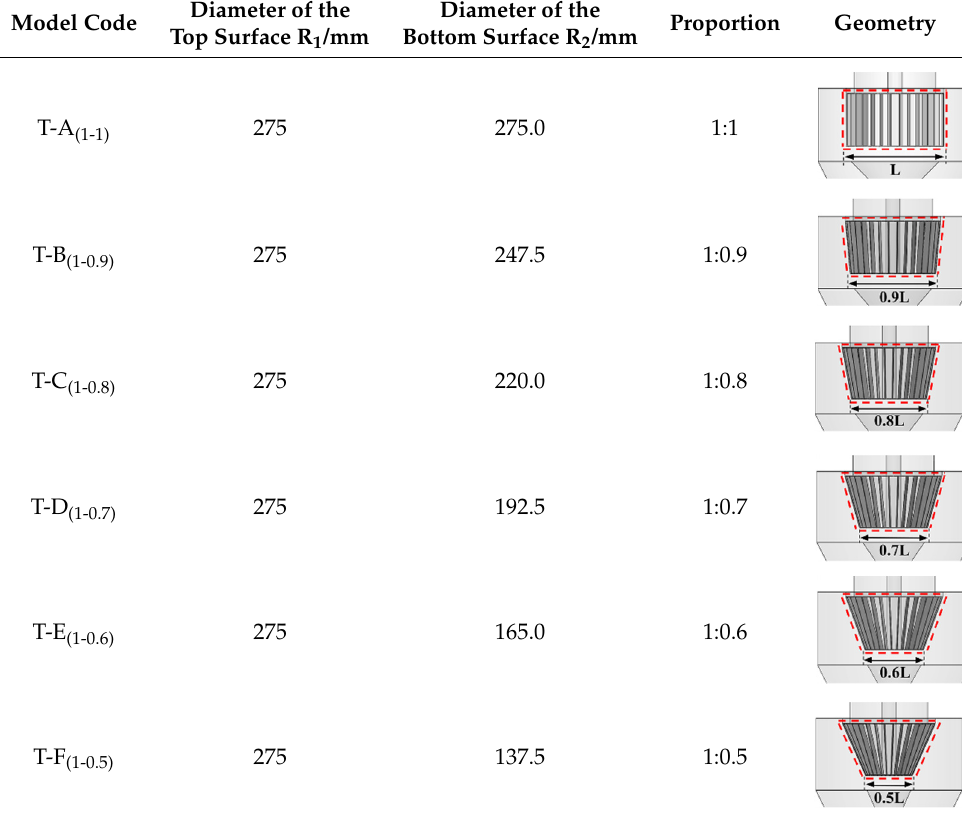
Table 1. Dimensional parameters of the rotor cage model.